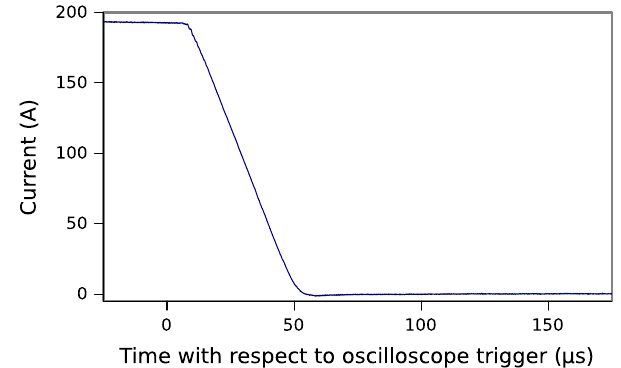
FIG. 16. Measured falling edge of current pulse from 193 A flat-top.